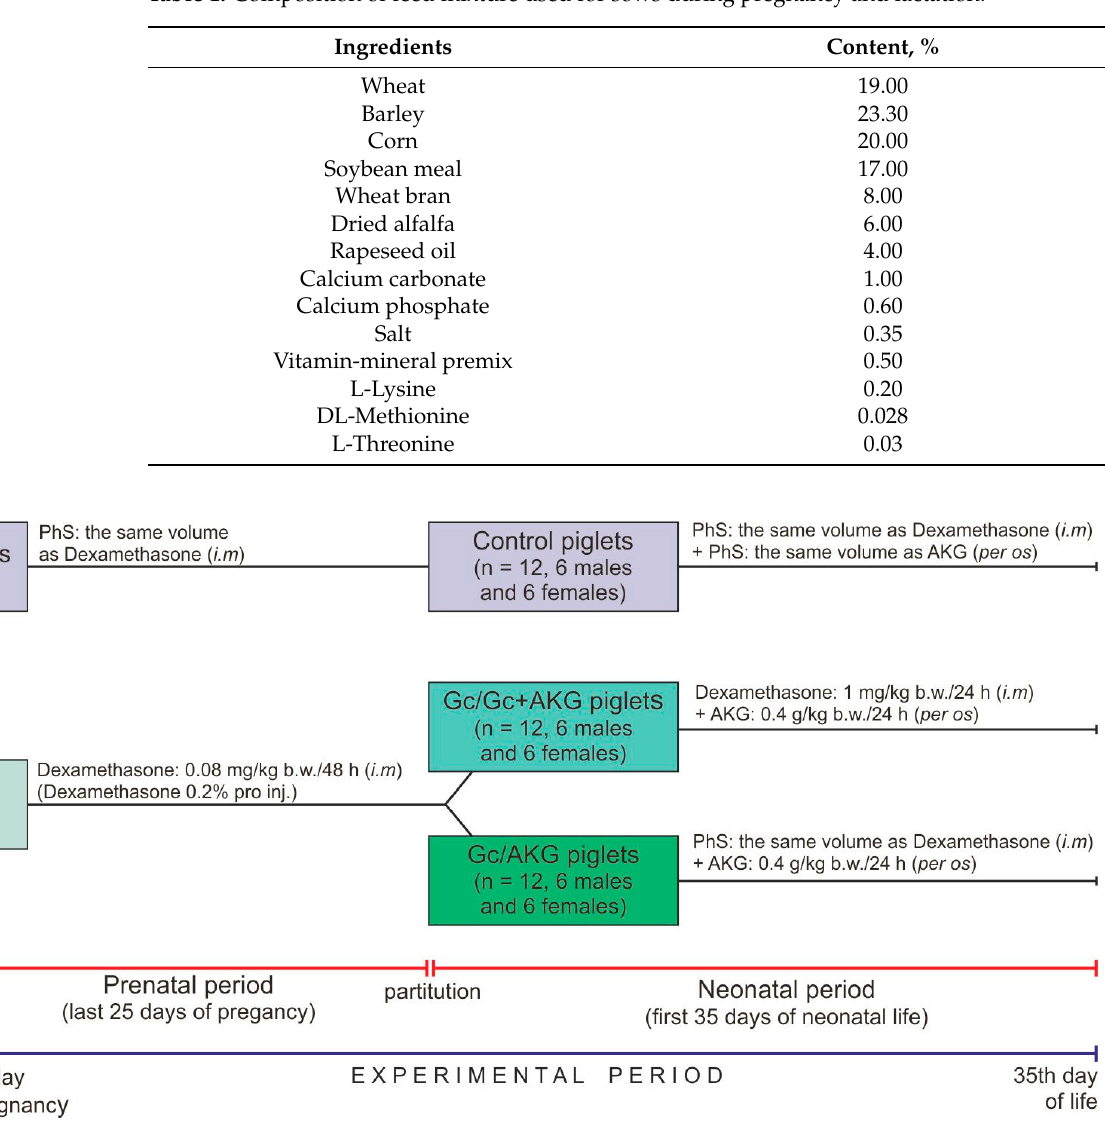
Figure 1. Scheme showing the experimental design. From the 90th day of gestation to parturition dexamethasone was administered to n = 4 sows belonging to Gc group at the dose 0.08 mg /kg b.w. every second day. After delivery, 24 newborns of Gc-treated sows were randomly assigned to one of the two groups: the Gc/Gc + AKG group receiving dexamethasone (1 mg/kg b.w./24 h i.m ) and supplemented with alpha-ketoglutaric acid (AKG) (0.4 g/kg b.w./24 h per os ) or the Gc/AKG group supplemented with AKG (0.4 g/kg b.w./24 h per os ) only, compromising of 6 males and 6 females each. Twelve piglets delivered by untreated control sows (n = 3) belonged to the control group. The experiment lasted until the 35th day of piglets’ neonatal life. Table 1. Composition of feed mixture used for sows during pregnancy and lactation.